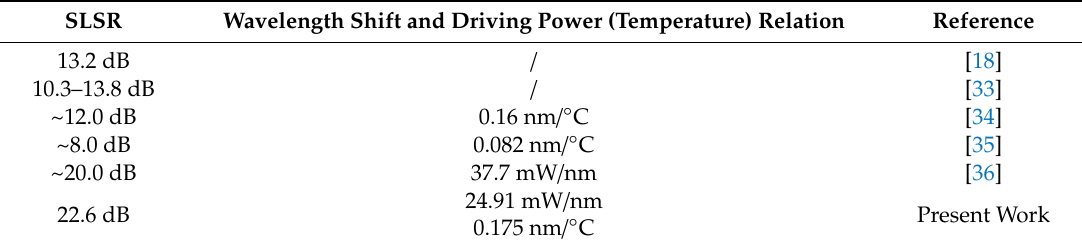
Table 2. Comparison of other published results for Bragg waveguide